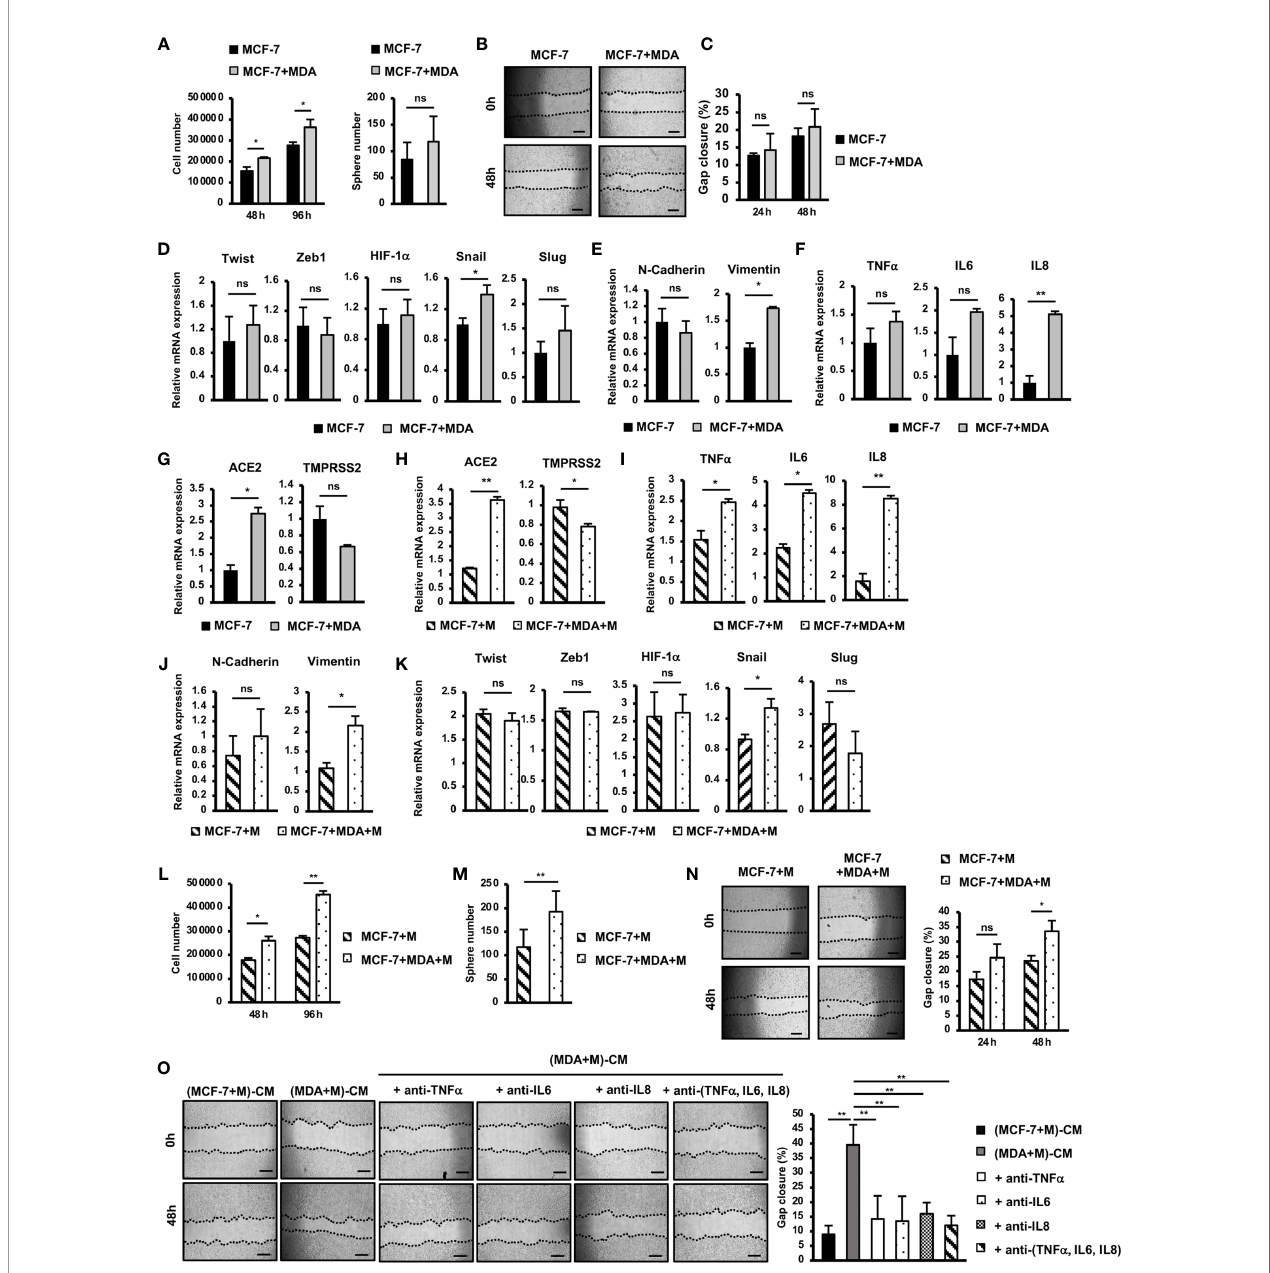
FIGURE 4 | SARS-CoV-2 M protein-treated MDA-MB-231 cells promoted the mobility, proliferation and stemness of MCF-7 cells. (A) Proliferation of MCF-7 cells cocultured with MDA-MB-231 cells. (B) A mammosphere assay of MCF-7 cells cocultured with MDA-MB-231 cells. (C) Migration of MCF-7 cells cocultured with MDA-MB-231 cells. (D) The mRNA expression of genes related to EMT process in MCF-7 cells cocultured with MDA-MB-231 cells. (E) The mRNA expression of EMT markers in MCF-7 cells cocultured with MDA-MB-231 cells. (F) Gene expression of in fl ammatory cytokines in MCF-7 cells cocultured with MDA-MB-231 cells. (G) Gene expression of SARS-CoV-2 binding receptors in MCF-7 cells cocultured with MDA-MB-231 cells. (H) Gene expression of SARS-CoV-2 binding receptors in MCF-7 cells cocultured with M protein-treated MDA-MB-231 cells. (I) Gene expression of in fl ammatory cytokines in MCF-7 cells cocultured with M protein-treated MDA-MB-231 cells. (J) Gene expression of EMT markers in MCF-7 cells cocultured with M protein-treated MDA-MB-231 cells. (K) The mRNA expression of genes related to EMT process in MCF-7 cells cocultured with M protein-treated MDA-MB-231 cells. (L) Proliferation of MCF-7 cells cocultured with M protein-treated MDA- MB-231 cells. (M) Mammosphere assay of MCF-7 cells cocultured with M protein-treated MDA-MB-231 cells. (N) Migration of MCF-7 cells cocultured with M protein-treated MDA-MB-231 cells. (O) Migration of MCF-7 cells in conditioned medium (CM) from M protein-treated MCF7 cells or M protein-treated MDA-MB-231 cells in the presence of anti-TNF a antibody, anti-IL6 antibody and anti-IL8 antibody. The scale bars indicate 500 µm. Each value represents the mean ± SD of triplicate experiments. (ns, no signi fi cance; p > 0.05; *p ≤ 0.05; **p ≤